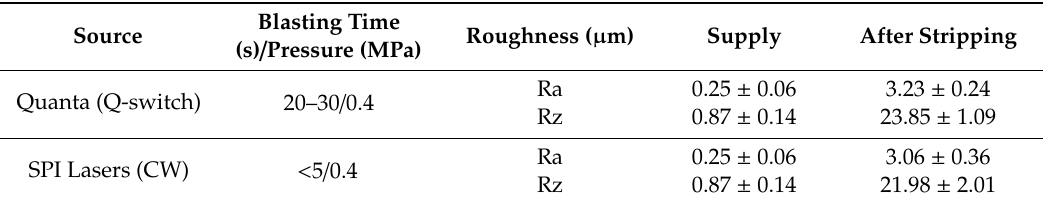
Table 7. Roughness values of EN-AW5754 substrates after laser stripping and after brown corundum blasting at 0.4 MPa.